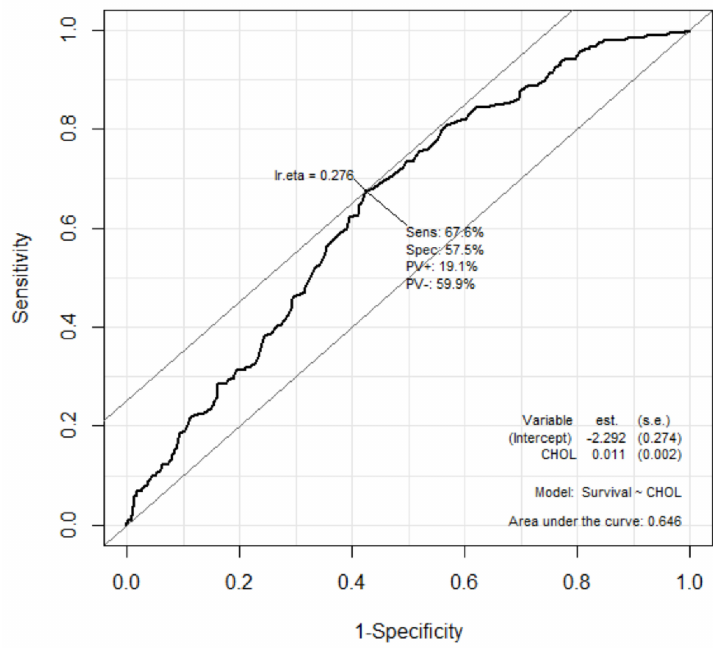
Figure 3. Receiver operator characteristic curve for prediction of survival to discharge using total cholesterol levels. The optimal cut-off value of the total cholesterol level for predicting good neu- rologic outcomes using the Youden’s index was calculated as 126 mg/dL, and for predicting poor neurologic outcomes with high specificity was calculated as 58 mg/dL (Table 3).